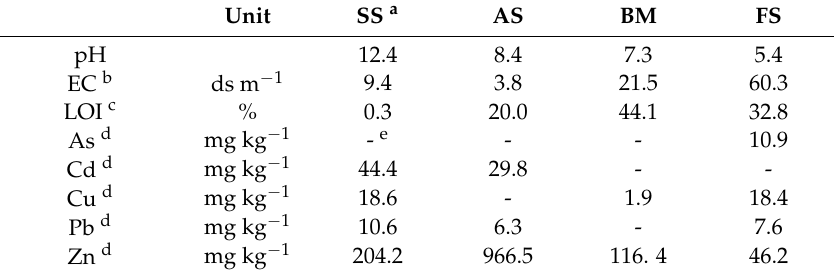
Table 3. Basic properties and trace element concentrations of the